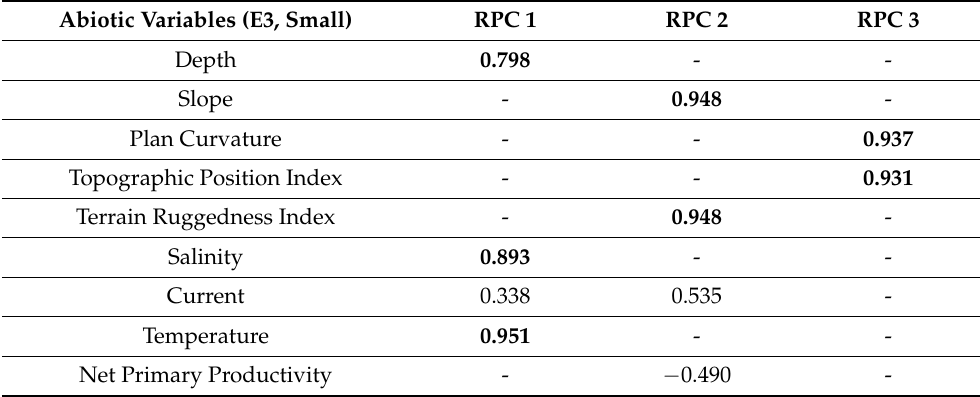
Table 7. Rotated components matrix. Correlation between the original input variables and the Varimax rotated principal components for the smaller study area. Values with r > 0.7 or r < − 0.7,